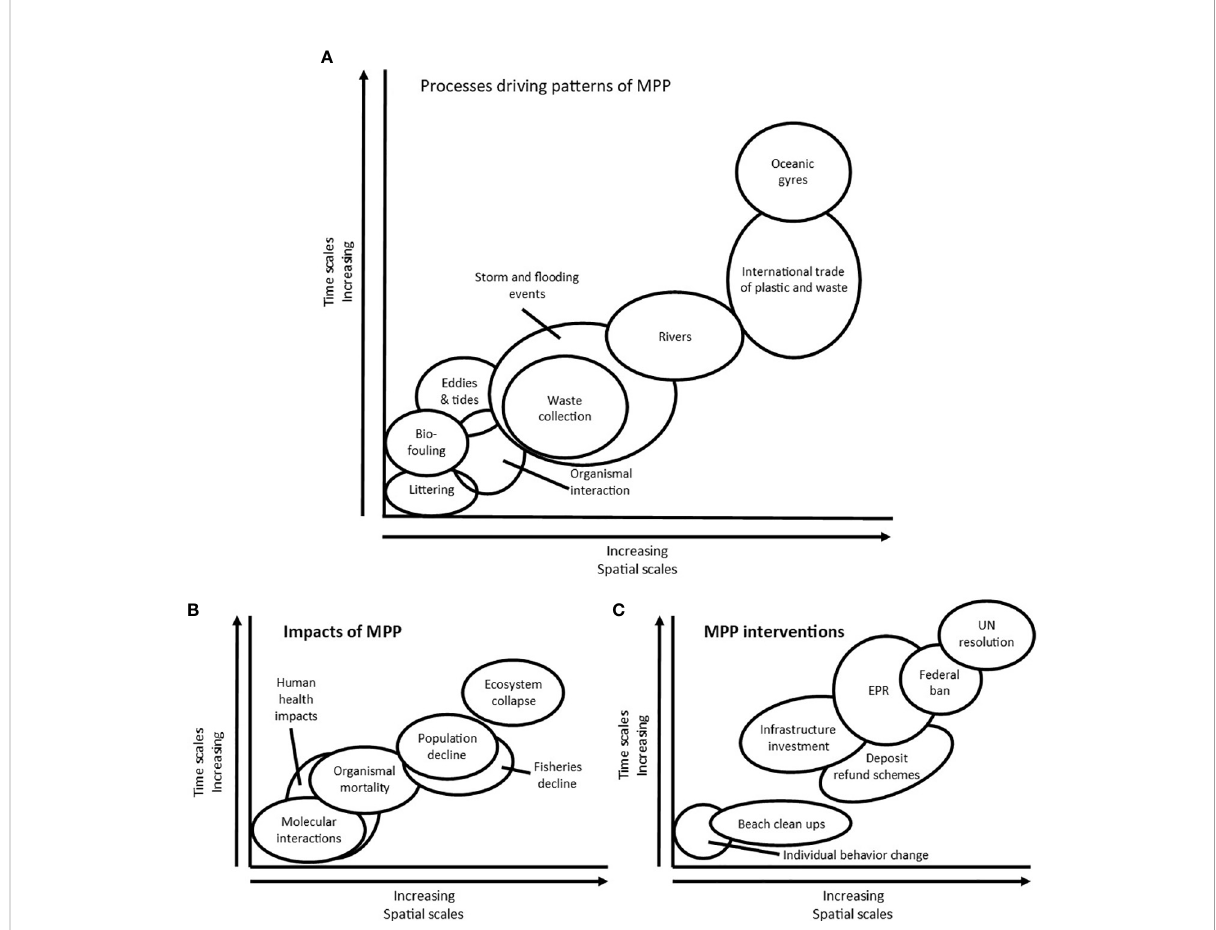
FIGURE 2 Time-space diagrams showcasing the multi-scale nature of the plastic-scape. (A) Provides examples of anthropogenic and natural processes that drive the spatial arrangement of marine plastic pollution. (B) Provides examples of the social-ecological impacts of plastic pollution. (C) Provides examples of marine plastic pollution management